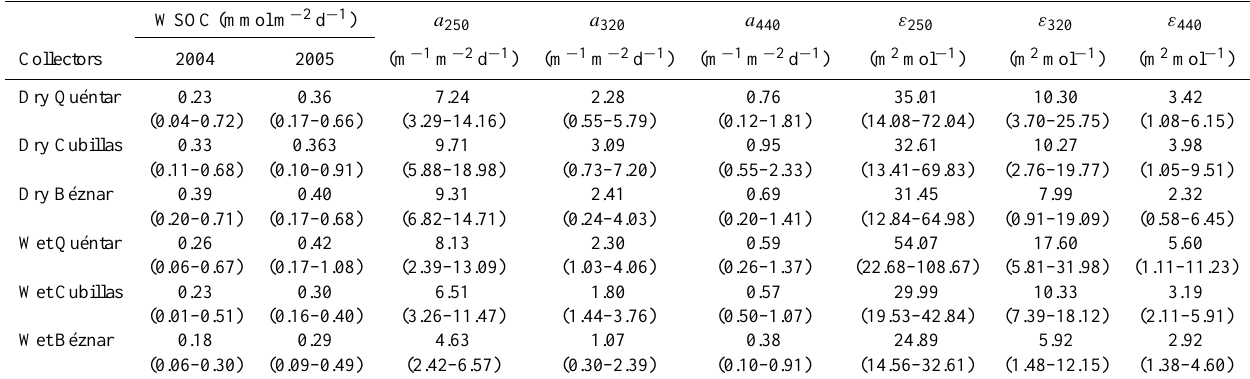
Table 2. Average values and range (in parentheses) of atmospheric inputs of water-soluble organic carbon (WSOC) in 2004 and 2005 and absorption coefficients at 250nm ( a 250 ) , 320nm ( a 320 ) and 440nm ( a 440 ) in the dry and wet atmospheric collectors placed near the study reservoirs in